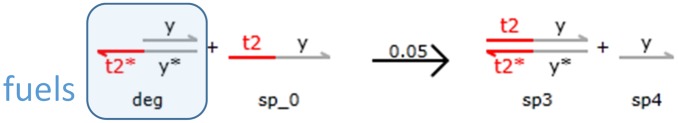
DSD realization of the degradation reaction.Here, deg serves as fuel with its concentration maintained at a fixed value and corresponds to catalysts z
±. In the reaction, the rate constant equals the toehold binding rate 0.05 nM−1 s−1.